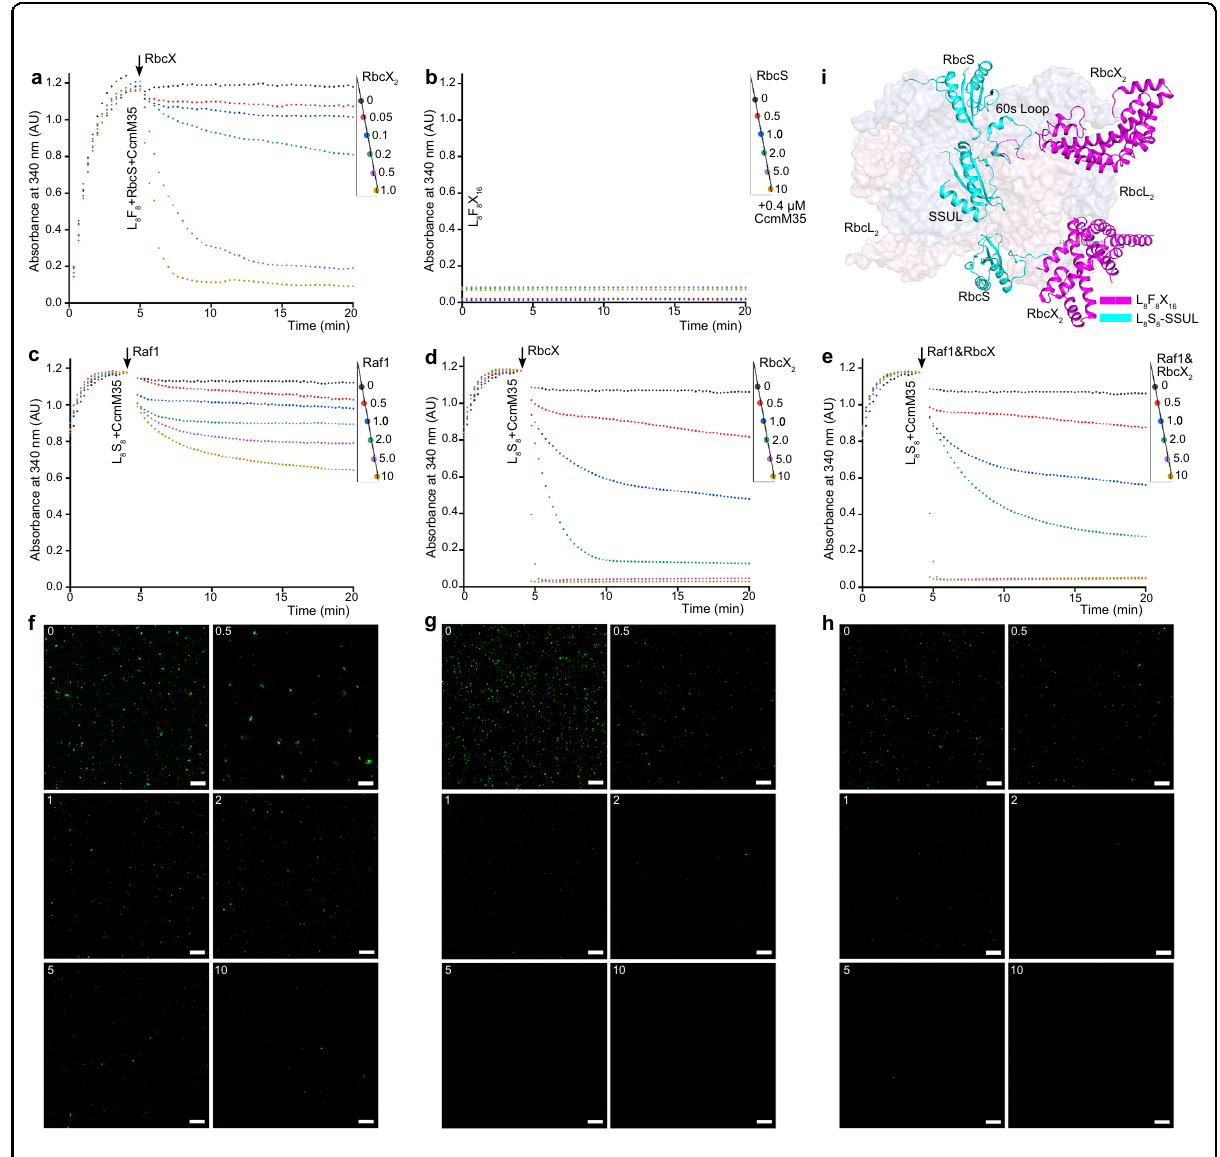
Fig. 3 Effects of Raf1 and RbcX on solubilizing the CcmM35-mediated condensates of RuBisCO. a Plots of solubilizing Anabaena sp. PCC 7120 RuBisCO condensates upon addition of RbcX. The RuBisCO condensates were formed by mixing 0.5 µM L 8 F 8 , 4 µM RbcS, and 4 µM CcmM35 for 5 min. RbcX 2 at various concentrations (0, 0.2, 0.4, 0.8, 2 and 4 μ M), corresponding to a molar ratio of 0, 0.05, 0.1, 0.2, 0.5 and 1 fold RbcX 2 to RbcL, respectively, was then added to the turbid solution. b Plots of condensate formation from Anabaena sp. PCC 7120 L 8 F 8 X 16 was incubated with RbcS for 30 min, and then 4 µM of CcmM35. 0.5 µM L 8 F 8 X 16 was incubated with RbcS at various concentrations (0, 2, 4, 8, 20 and 40 µM), corresponding to a molar ratio of 0, 0.5, 1, 2, 5 and 10 fold RbcS to RbcL, respectively. c – e Plots of S. elongatus PCC 7942 RuBisCO condensate solubilization upon adding Raf1 ( c ), RbcX ( d ) and Raf1&RbcX ( e ), respectively. The RuBisCO condensates were formed by mixing 0.25 µM L 8 S 8 and 2 µM CcmM35 for 4 min. Raf1, RbcX 2 and Raf1&RbcX 2 at various concentrations (0, 1, 2, 4, 10 and 20 μ M), corresponding to a molar ratio of 0, 0.5, 1, 2, 5, and 10 fold Raf1 or RbcX 2 to RbcL, respectively, were then added to the turbid solution. The turbidity was monitored at 340 nm over time. f – h Confocal microscopy images of the fi nal condensates corresponding to c – e . Scale bars, 20 μ m. i Structural superposition of L 8 F 8 X 16 against L 8 S 8 – SSUL complex (PDB, 6HBC). The RbcL dimer is shown as surface and colored in pink/blue. The SSUL domain and 60s loop of RbcL from L 8 S 8 – SSUL complex are indicated by cyan cartoon, whereas the Raf1 α domains and 60s loops of RbcL from L 8 F 8 X 16 are shown as a magenta